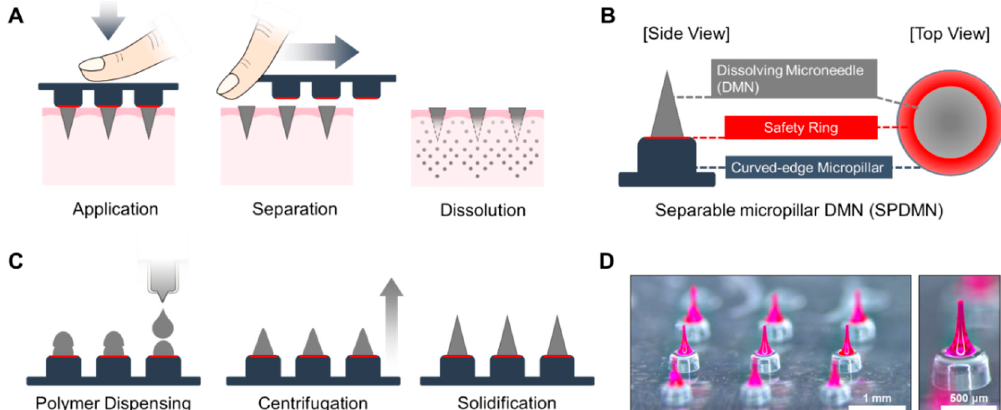
Figure 1. Application and characterization of SPDMNs. ( A ) Separation of DMNs from micropillars can be immediately achieved post-insertion through a lateral force. ( B ) A 200 µ m safety ring surrounds the DMNs over the micropillars to ensure that only DMNs and not micropillars are inserted into the skin. The curved-edge characteristic of the micropillars is designed to minimize skin friction during the separation process. ( C ) The fabrication process of SPDMNs through centrifugation. ( D ) Actual microscope images of a 3 × 3 SPDMN array and a single SPDMN. Scale bars are 1 mm (left panel) and 500 µ m (right panel).